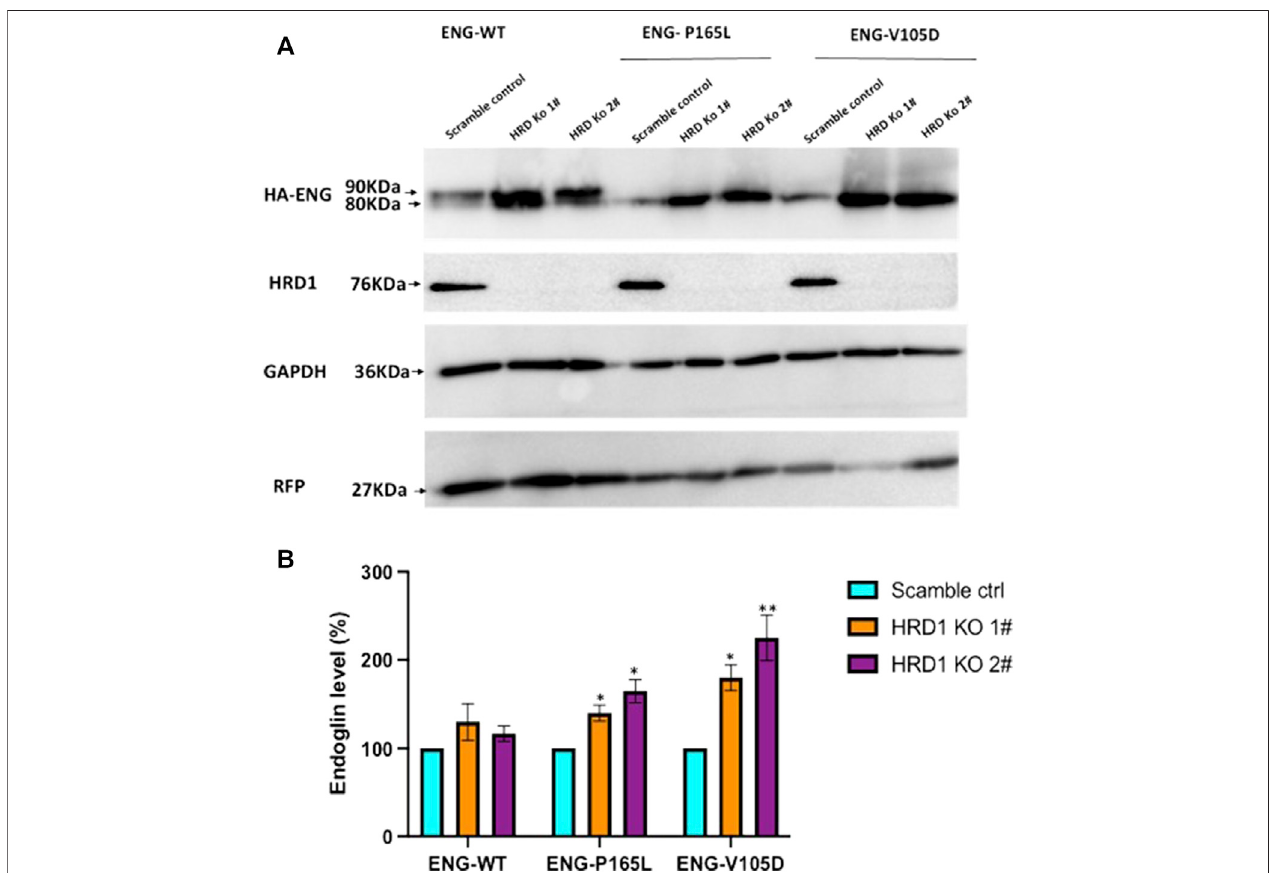
FIGURE6| EndoglinWTandmutantvariantsaccumulationlevelinHEK293 HRD1-KO cells. (A) GeneratedHRD1-Knockouts(1#and2#)weretransientlytransfected with pcDNA3.0 plasmid vectors harboring WT Endoglin and mutant variants (P165L and V105D). Total cell lysate was analyzed by immunoblotting against HA-ENG, RFP, GAPDH, and HRD1 (B) Bar graphs representing mean densities of WT Endoglin and mutants normalized with GAPDH (loading control) and RFP (For transfection ef fi ciencycontrol).Endoglin levelwasexpressed in(%)relative to(scramblecontrol).BarsrepresentSEMfrom 4differentExperiment( n =4). Statisticalsigni fi cance for Endoglin accumulation level in each cell line (relative to scramble control) was assessed using one sample t-test, (*) p ≤ 0.05; (**); p ≤ 0.01; (***) p ≤